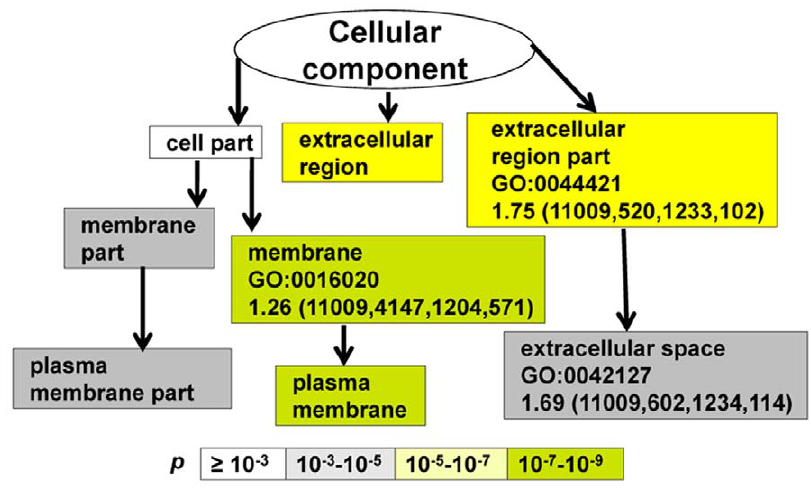
Figure 7. Cellular components affected by ER silencing. See legend to Figure 6.